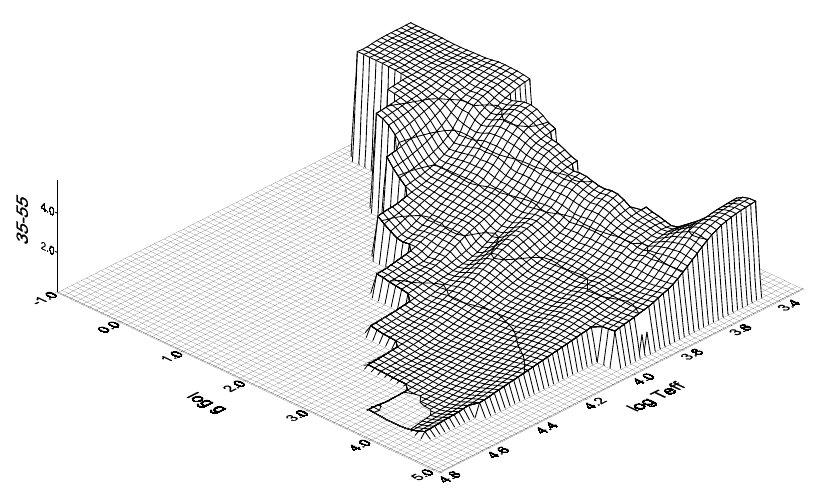
Fig. 3. Three-dimensional diagram of the color index 35–55 versus log T e and log g . The five curves on the surface correspond to the 35–55 values of 1, 2, 3, 4 and 5.